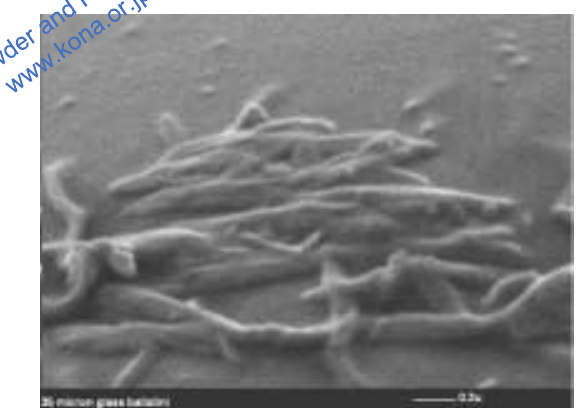
Fig. 6 SEM image of the contact site of a glass sphere directly after the repulsion and peak adhesion were observed. The features are proposed to be glass corrosion products that have spontaneously formed by crystallisation from the supersaturated liquid layer on decreasing the